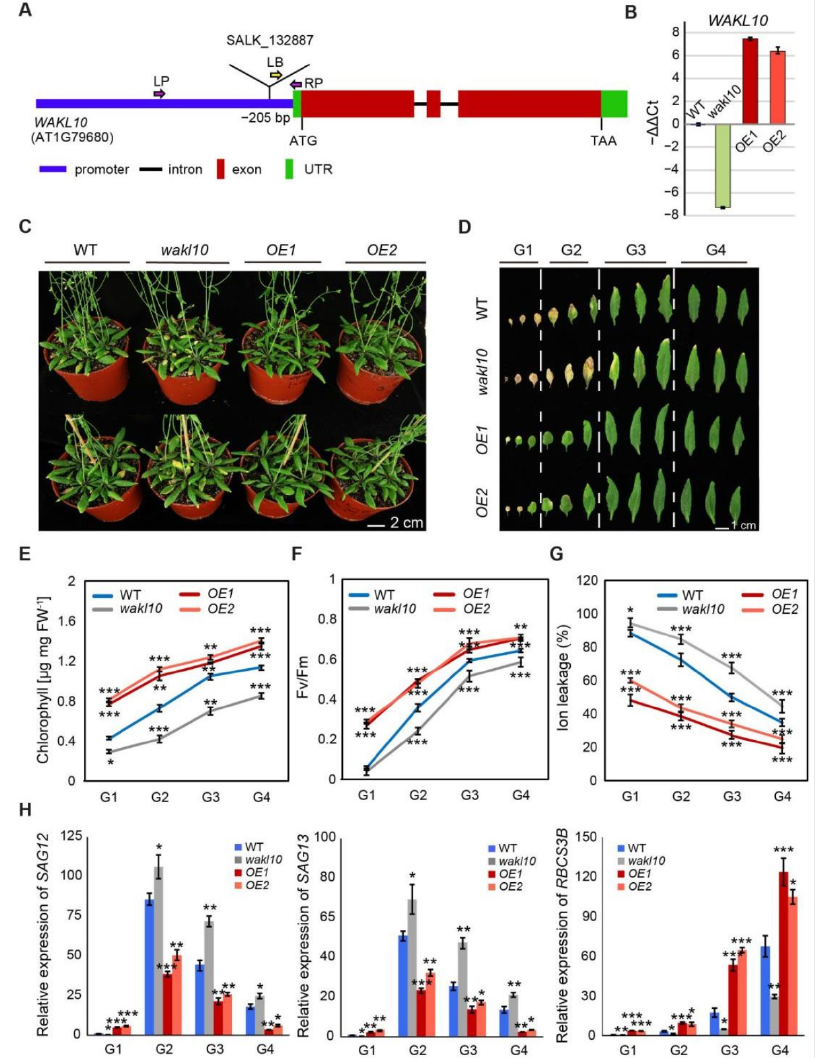
Figure 4. AtWAKL10 negatively regulated natural leaf senescence. ( A ) Schematic gene model of AtWAKL10 . The T-DNA insertion site was shown, and homozygous mutants were screened using specific primers (Supplementary Table S1). LP (left primer), RP (right primer), left border primer (LB), ATG (start codon), TAA (stop codon) and UTR (untranslated region). ( B ) Quantification of AtWAKL10 in atwakl10 mutant and AtWAKL10 overexpression lines. Expression levels of AtWAKL10 were determined by qRT-PCR and presented as values of − ∆∆ Ct. Data shown were means ± SE of three independents plants. ( C ) Phenotypes of 7-week-old wild type (Col-0), atwakl10 mutant and AtWAKL10 overexpression lines ( OE1 and OE2 ), and ( D ) a series of developmental stages of all leaves as indicated. Rosette leaves were divided into four groups according to the degree of senescence. Quantification of chlorophyll concentrations ( E ), PSII maximum efficiency (Fv/Fm) ( F ), ion leakage ( G ) and relative expression of SAG12, SAG13 and RBCS3B ( H ) in leaves from each group. Mean values ± SE were shown for three biological replicates. Significant differences (* p < 0.05, ** p < 0.01, and *** p < 0.001) compared with the wild type in each group were determined by Student’s t